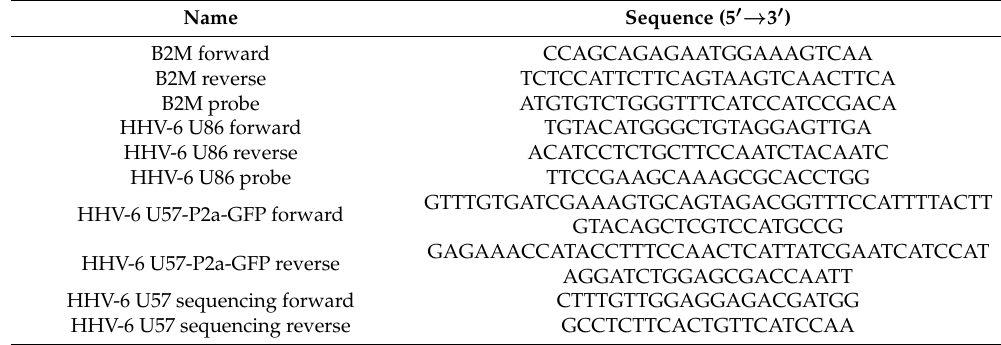
Table 1. List of oligonucleotide primers and probes used for qPCR, mutagenesis, and